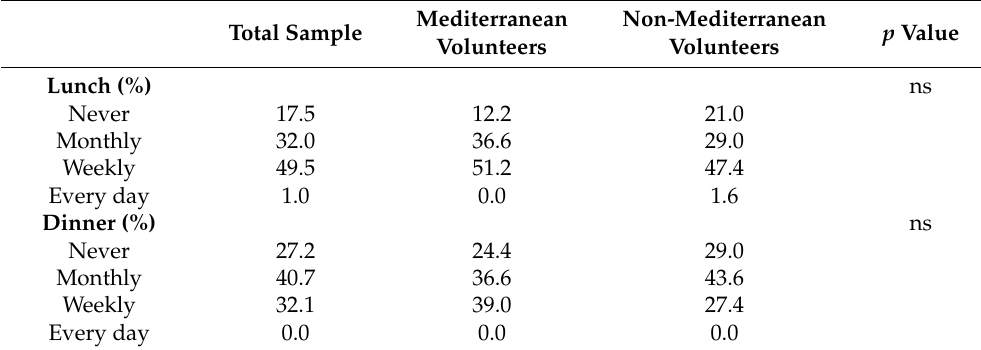
Table 5. Away-from-home eating by geographical area of origin.